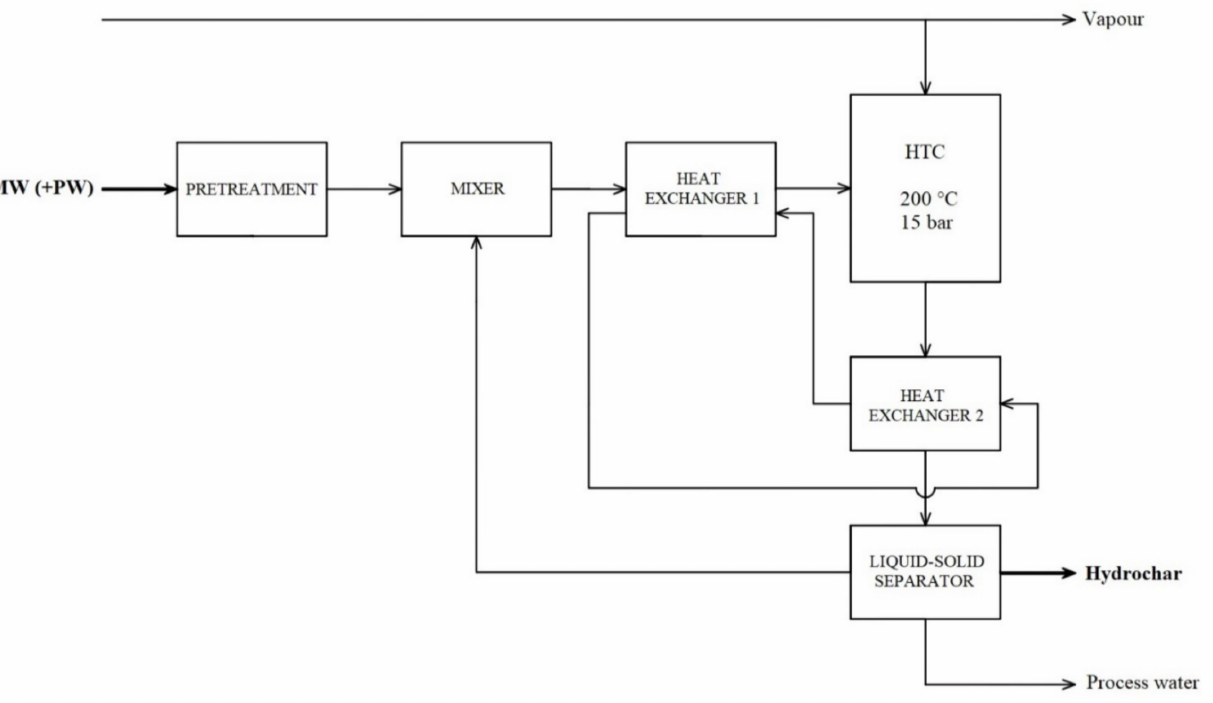
Figure 8. Blok diagram of the continuous HTC process of SOMW, TCW or mixtures of them, equipped with a double exchanger for heat recovery. The double heat exchanger aims to prevent the formation of deposits of dirty material on the shell